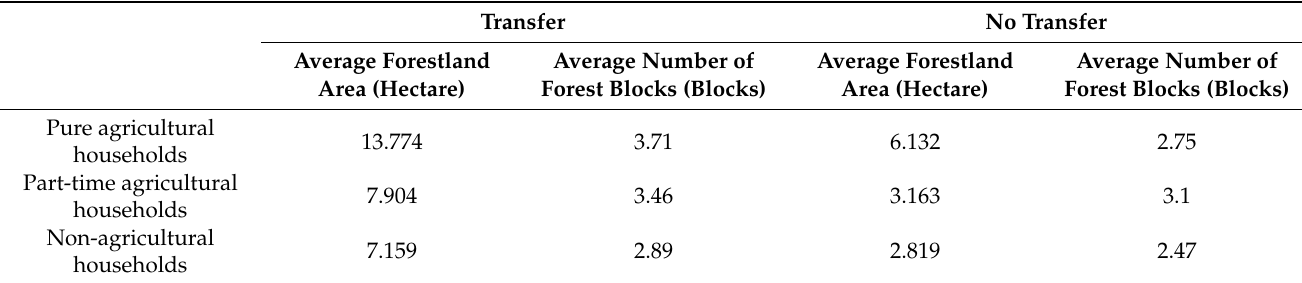
Table 5. Forestland transfer and forestland resources of agricultural households.